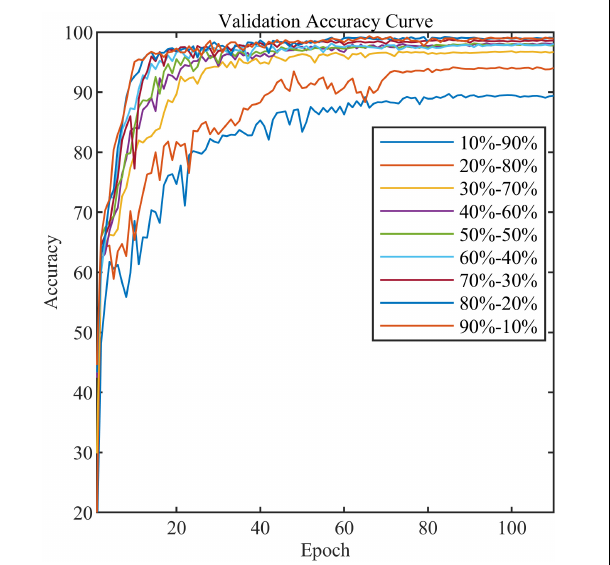
FIGURE 11 | The validation accuracy curve of the standard model in nine train-validation sets.